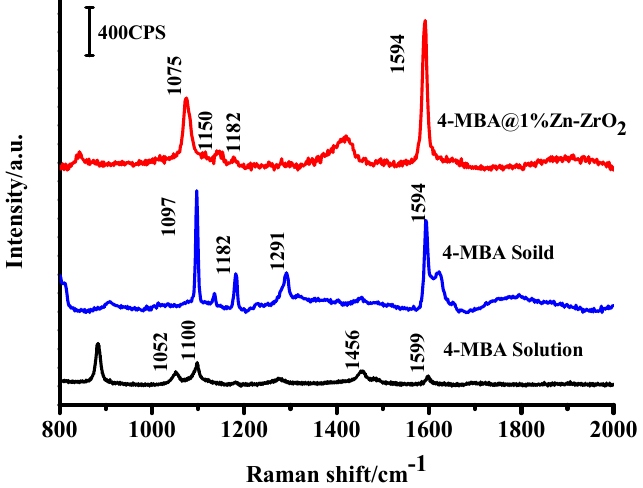
Figure 9. The SERS spectra of 4–MBA adsorbed on the Zn–ZrO 2 (1%) NPs, the 4–MBA bulk sample and ethanol solution (1 × 10 − 1 M).